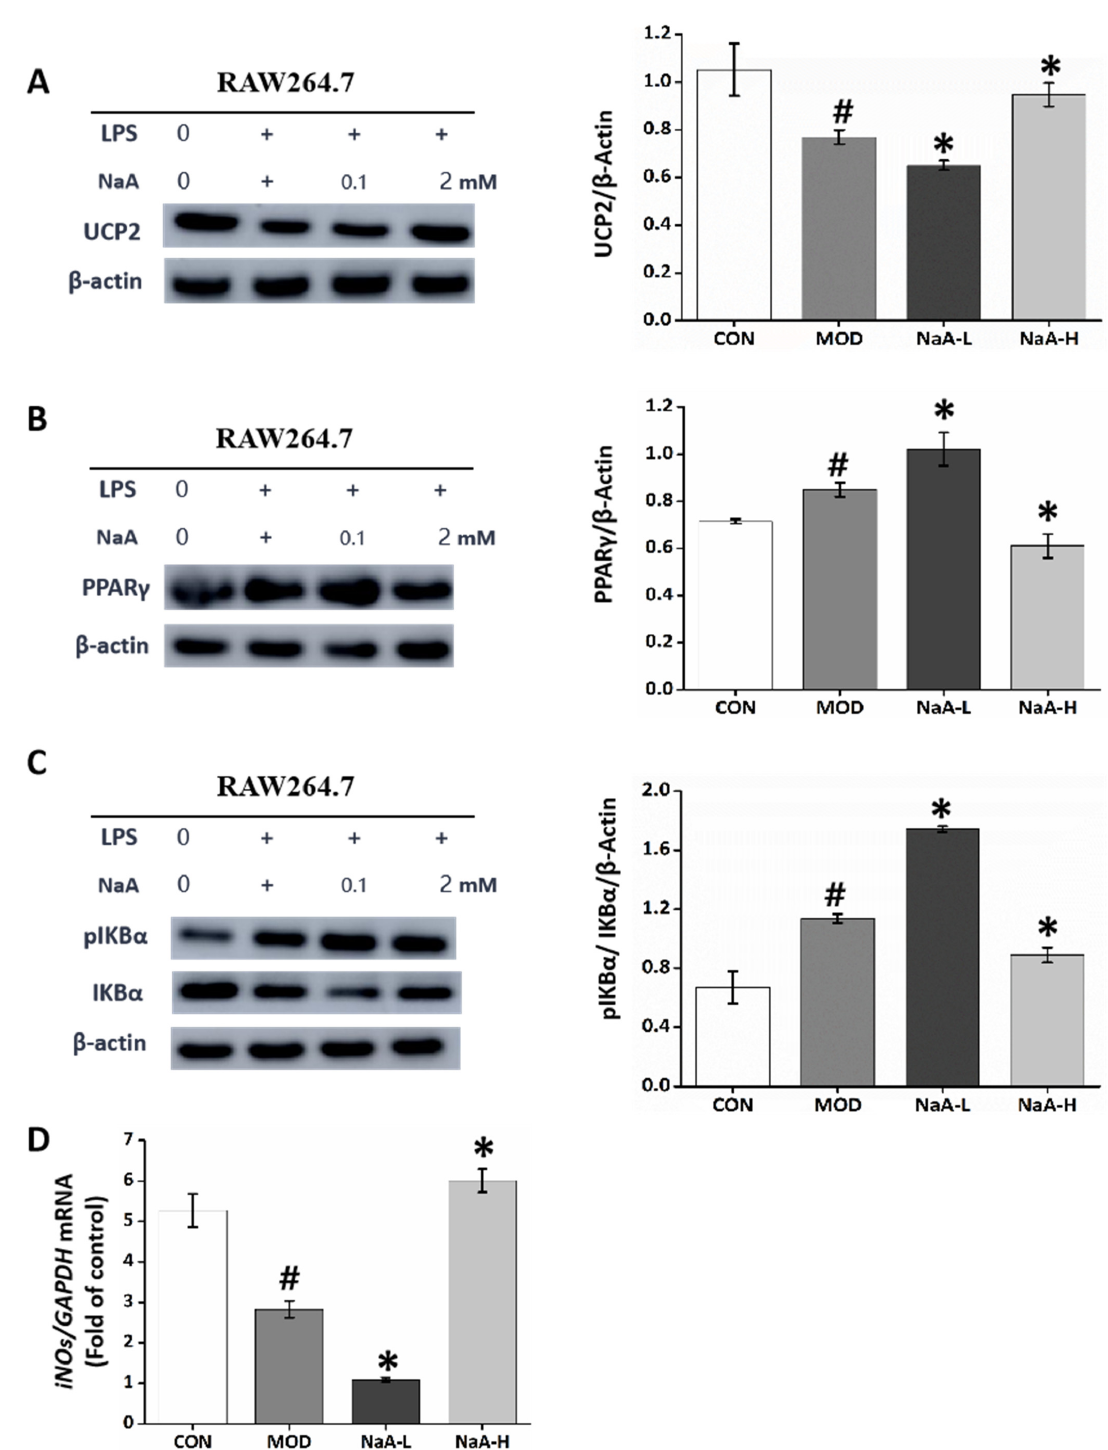
Figure 6. NaA affectsAMPK-related pathways to regulate inflammatory responses in